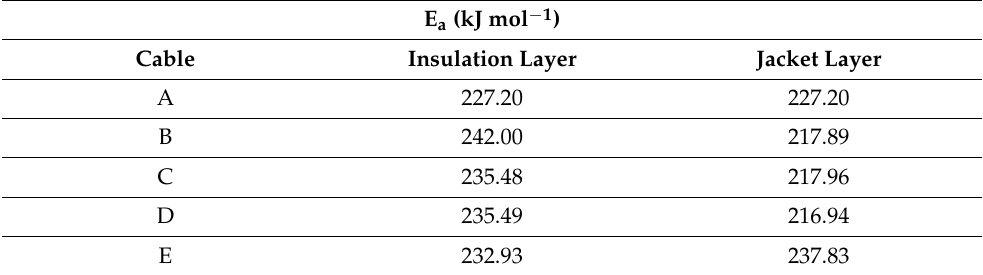
Figure 5. Kissinger plots ( a ) insulation layer ( b ) jacket layer. A–E stand for different ESP cables as denoted in the Section 2. Table 3. Activation energies of the insulation and jacket layers, as calculated by the Kissinger method.